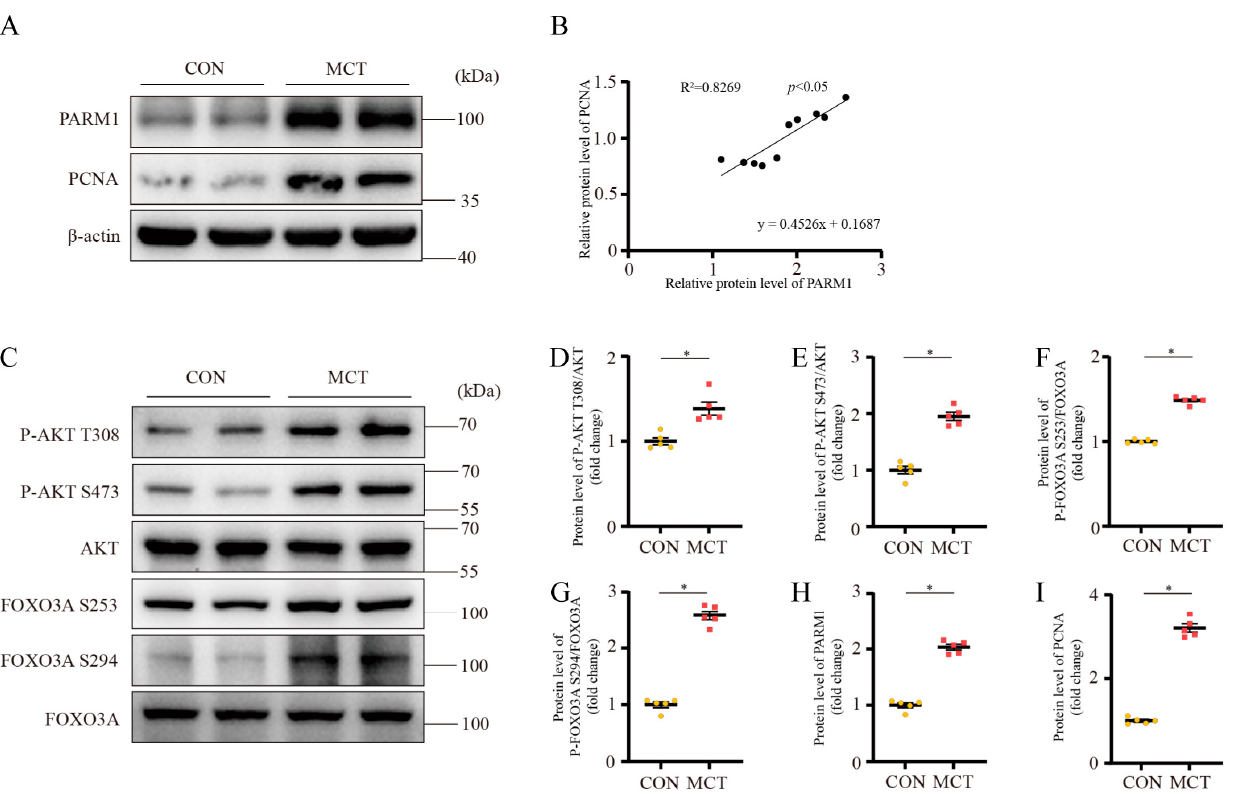
Figure 6. Screening of a novel therapeutic target for the PAH rat model. ( A , H , I ) Representative Western blots and analysis of PARM1 and PCNA expression in rat lung. Equal protein loading was confirmed using an anti- β -actin antibody (n = 5 each). ( B ) Linear regression analysis of the association between PARM1 and PCNA expression in rat lung. ( C – G ) Representative Western blots and analysis of p-AKT(T308)/AKT ratio; p-AKT(S473)/AKT ratio; p-FOXO3A(S253)/FOXO3A ratio; p-FOXO3A(S294)/FOXO3A ratio in rat lung. Data are shown as mean ± SEM (n = 5 each); * p < 0.05 vs. CON group (student’s t -test).